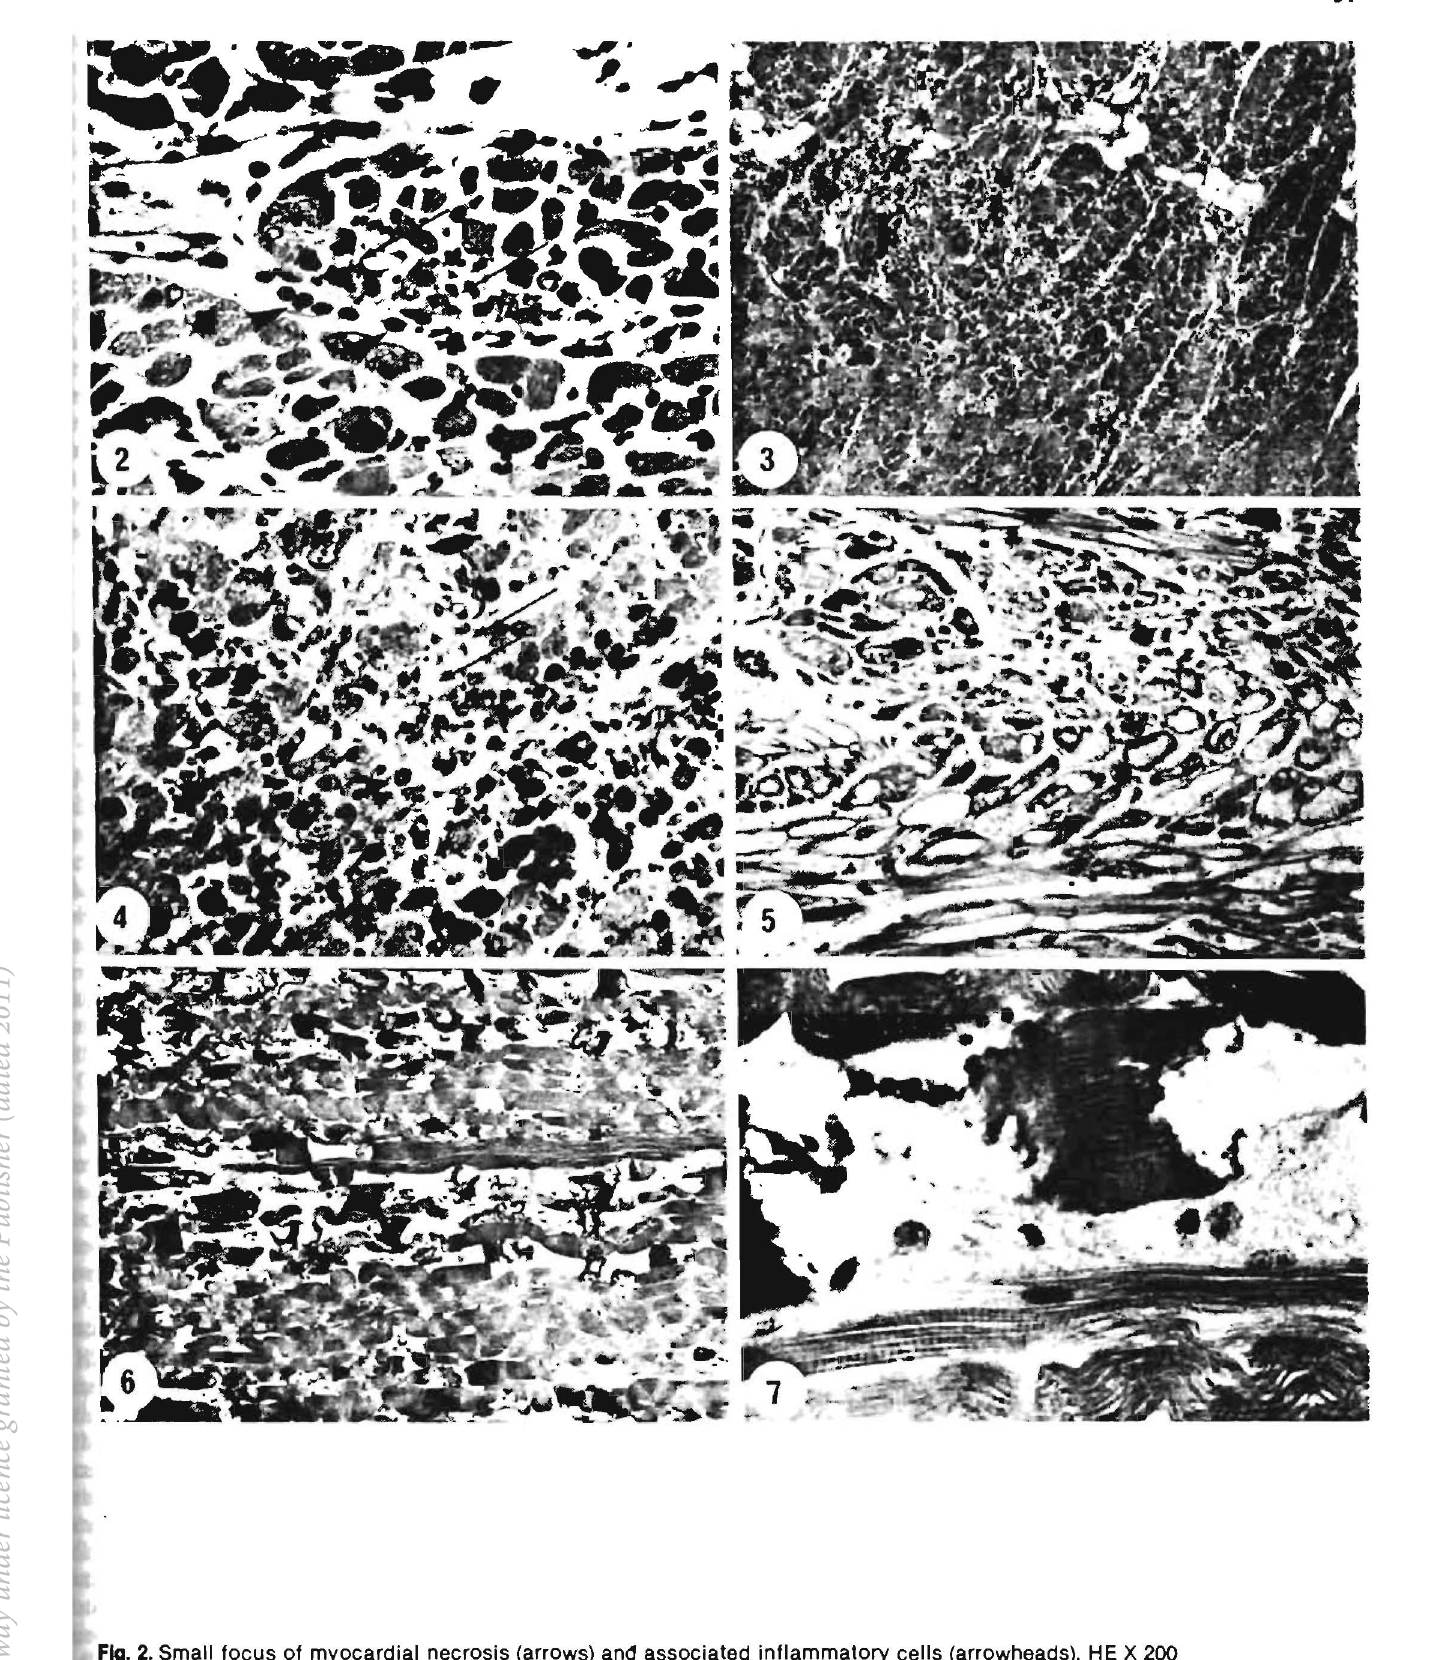
Fig. 2. Small focus of myocardial necrosis (arrows) and associated inflammatory cells (arrowheads). HE X 200 FIg. 3. Extensive myocardial necrosis and mild inflammatory cell infiltrates; necrotic myofibres appear dark. HE X 50 FIg. 4. Area of necrotic myocardial fibres and myoflbre loss (arrows). HE X 200 fig. 5. Vacuolation of myocardial fibres. HE X 200 Fig. 8. Extensive fragmentation of myoflbres; semimembranosus muscle. HE X 100 fig. 7. Sarcoplasmic fragmentation, lysis and mild inflammatory cell infiltrate; semimembranosus muscle. HE X 1 000 JOURNAL OF THE SOUTH AFRICAN VETERINARY ASSOCIA nON - MARCH